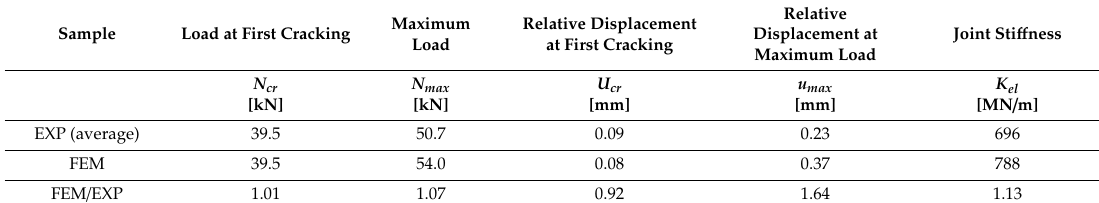
Experimental results for the tested specimens [13] and numerical FE predictions (ABAQUS / Standard).